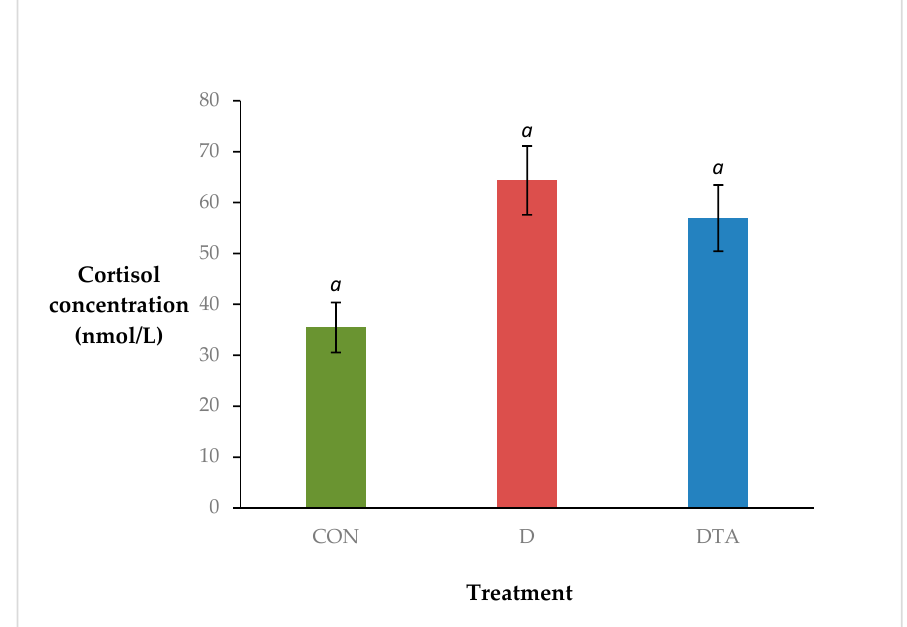
Figure 2. Cortisol concentration (nmol/L ± s.e.m.) of all calves prior to treatment, and at 40 min, 1.5 h, 4 and 24 h post-treatment. Time points with different superscripts are significantly different ( p < 0.05). There was a statistical tendency for a treatment e ff ect on cortisol response ( p = 0.079; s.e.d. = 12.88) (Figure 3). Overall, the lowest cortisol concentrations were secreted by CON calves, the highest from D calves, and DTA calves were intermediate to both (mean 35, 64 and 57 nmol / L, respectively). Animals 2020 , 10 , 312